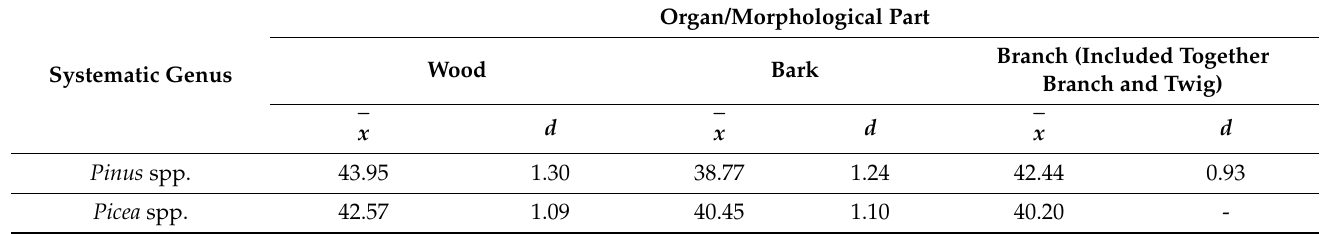
Table A18. Average value and average deviation of the oxygen content (% d.m.) in various organs of particular systematic genera